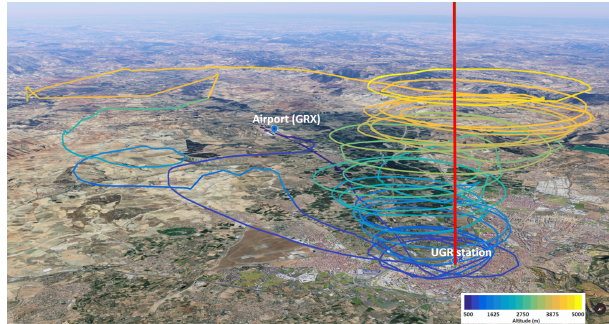
Figure 1. Map illustrating the UGR station. The coloured line indi- cates the trajectory of the aircraft and its altitude during the SLOPE II campaign. The red line indicates the vertical of the lidar measure- ments. © Google